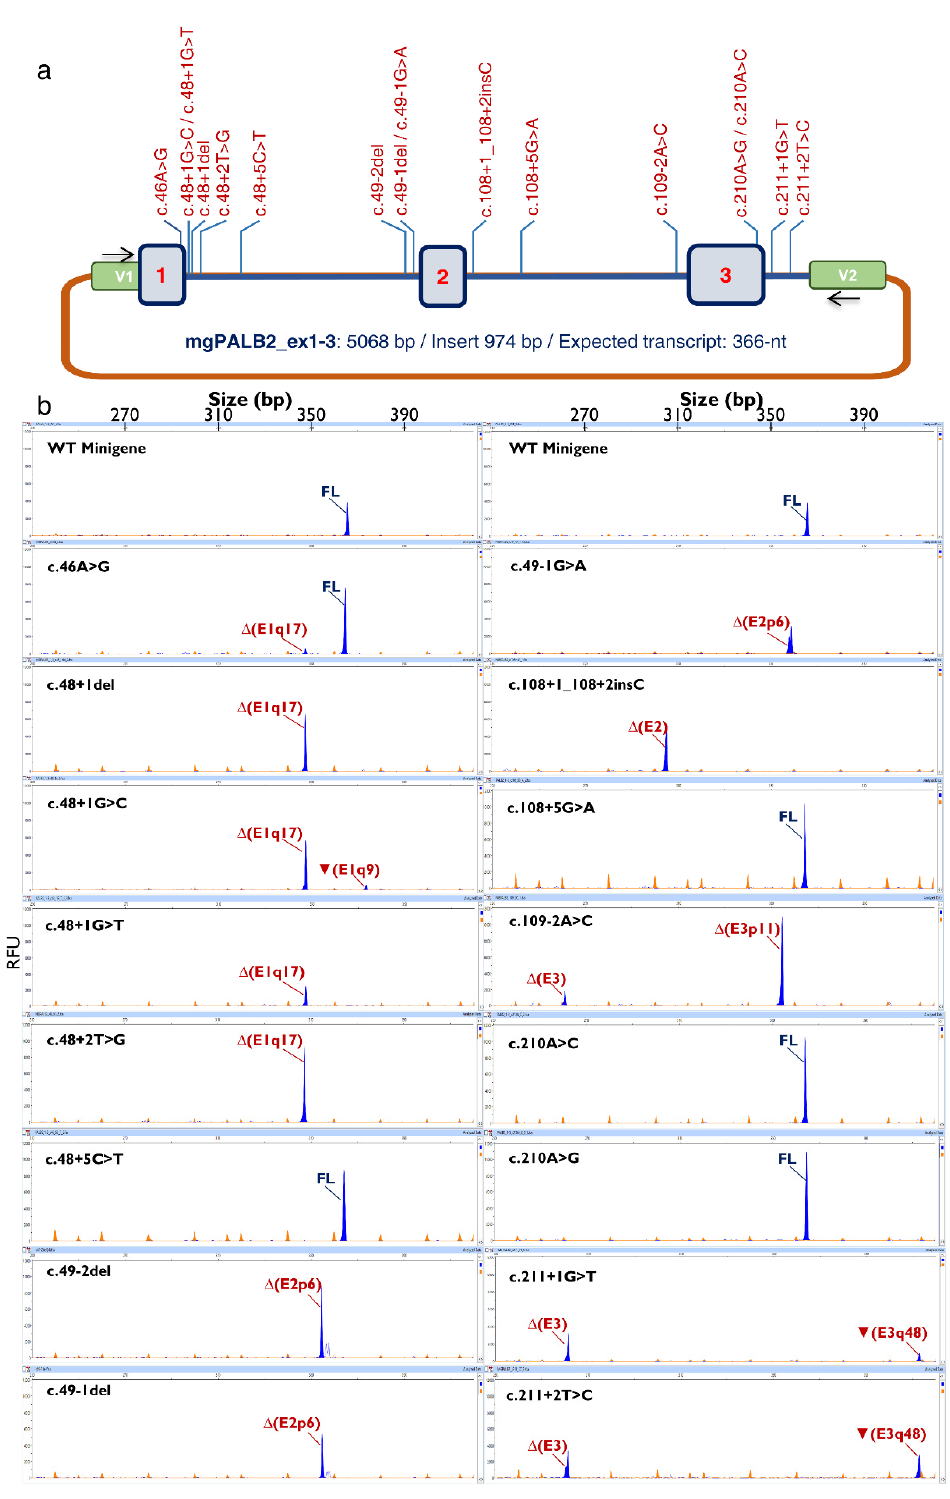
Figure 1. Minigene splicing assays of selected PALB2 variants. ( a ) Map of variants in the minigene mgPALB2_ex1–3. V1 and V2 are the vector exons while variants are shown in red above the minigene construct ( b ) Fluorescent fragment analysis of 16 variants. The electropherogram of the wild-type minigene is shown on the top of each column. FAM-labelled products (blue peaks) were run together with LIZ-600 (orange peaks) as size standard (FL, minigene full-length transcript). The x-axis indicates size in bp (electropherograms on the top) and the y-axis represents relative fluorescence units (RFU).